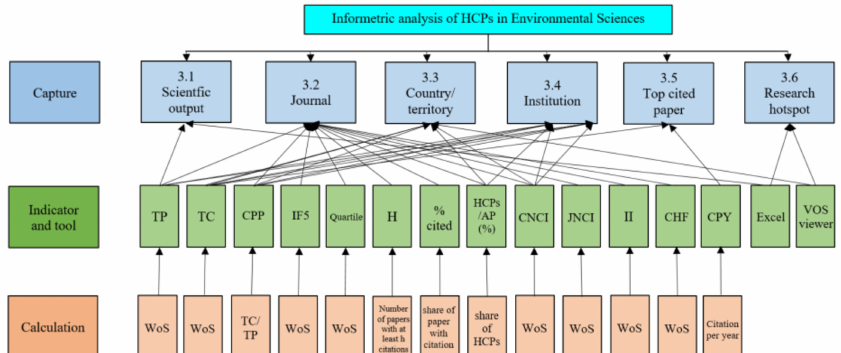
Figure 1. Analysis structure and indicators used in the study. TP: the number of publications;